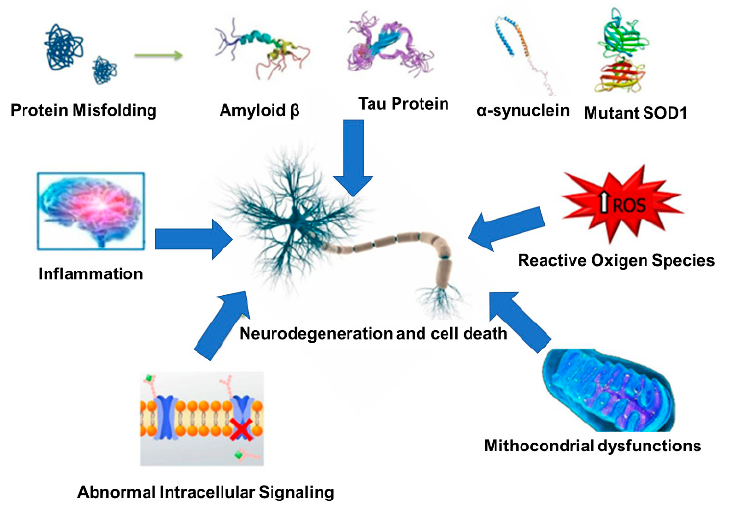
Figure 1. Processes that lead to neurodegeneration and cell death: protein misfolding (specifically related to Amyloid β , Tau protein, α -synuclein, and SOD1), increase in reactive oxygen species, mitochondrial dysfunction, inflammation, and aberrant intracellular signaling.